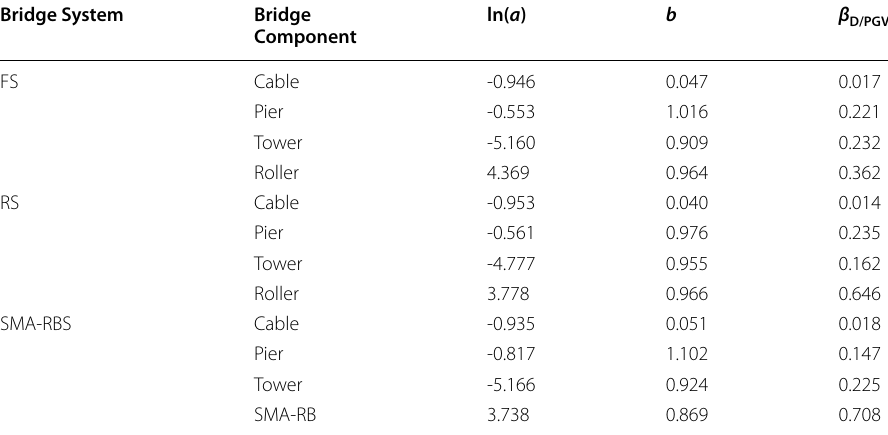
Table 4 Regression coefficients of PSDMs for bridge components Bridge System Bridge